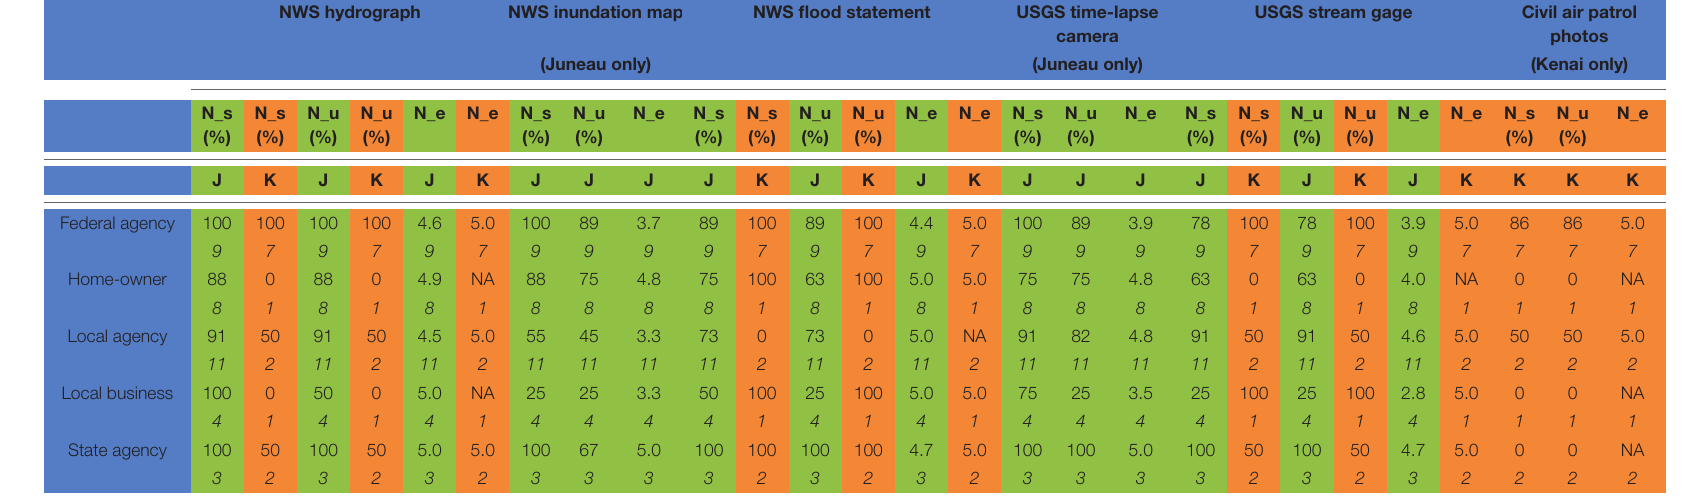
TABLE 2 | Interviewee use and understanding of information products, by type of organization for the cumulative Juneau ( n = 35, orange shading) and Kenai Peninsula ( n = 13, green shading) case